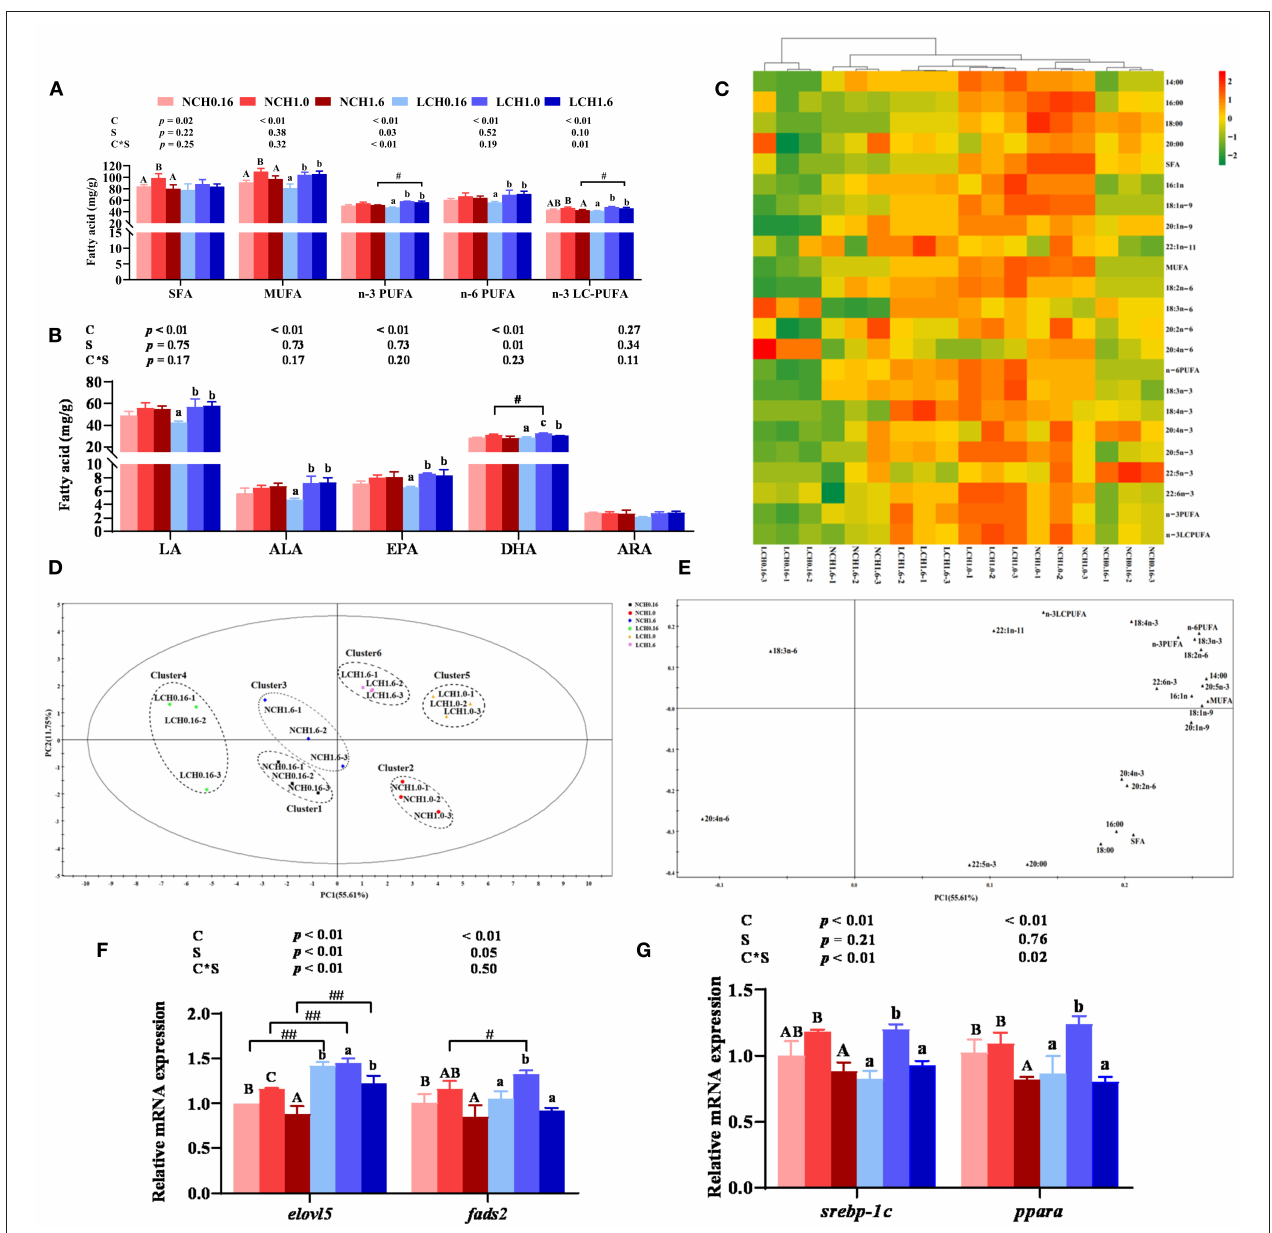
FIGURE 3 | Effects of dietary cholesterol level and water salinity on LC-PUFA biosysnthesis and hepatic fatty acid profiles of juvenile black seabream ( Acanthopagrus schlegelii ). Main fatty acid profile in liver (A) and (B) , hierarchical cluster analysis (HCA) and heat map visualization of the main fatty acid composition in liver (C) , principal component analysis (PCA) score plot (D) and loading plot (E) results of fatty acids in liver; hepatic relative gene expression levels involved in LC-PUFA biosynthetic pathway (F) and hepatic relative gene expression levels of lipid metabolism-related transcription factors. Cluster 1 represented as the NCH0.16 diet group, Cluster 2 represented as the NCH1.0 diet group, Cluster3 represented as the NCH1.6 diet group, Cluster 4 represented as the LCH0.16 diet group, Cluster 5 represented as the LCH1.0 diet group and Cluster 6 represented as the LCH1.6 diet group. Hierarchical cluster analysis (HCA) and heat map visualization (c) for Pearson’s correlation analysis of the correlation matrix of the fatty acid composition. The group of NCH0.16 was set as the reference group, and the mRNA expression levels of target genes were normalized relative to the expression of β -actin . Values are means ( n = 3) with standard errors represented by vertical bars. Two-way ANOVA P -values are shown in each panel, with “C” representing effects of dietary cholesterol levels, “S” representing effects of salinity, and “C*S” representing interaction between dietary cholesterol levels and salinity. “ABC” representing significant ( P < 0.05) difference between dietary cholesterol levels in normal water salinity (23 psu) and “abc” representing significant ( P < 0.05) difference between dietary cholesterol levels in low water salinity (5 psu) by performing one-way ANOVA. “#” representing significant ( P < 0.05) difference between water salinity with same dietary cholesterol level and “##” representing highly significant ( P < 0.01) difference between water salinity with same dietary cholesterol level by performing t -test. ARA, 20:4n-6; DHA, 22:6n-3; EPA, 20:5n-3; DHA/EPA, 22:6n-3/20:5n-3; LC-PUFA, long-chain polyunsaturated fatty acid (C20-24); MUFA, monounsaturated fatty acids; PUFA, polyunsaturated fatty acid; SFA, saturated fatty acids; elovl5 , elongase of very long chain fatty acids 5; fads2 , fatty acyl desaturase 2; ppar α , peroxisomeproliferator-activated receptor α ; srebp-1c , sterol regulatory element-binding protein 1c.